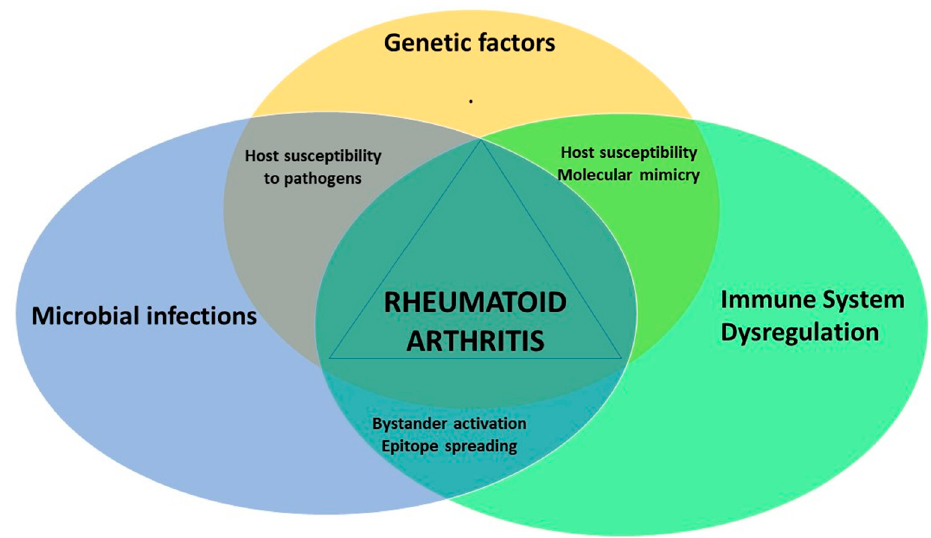
Figure 1. Interaction between di ff erent factors in driving rheumatoid arthritis (RA) pathogenesis.